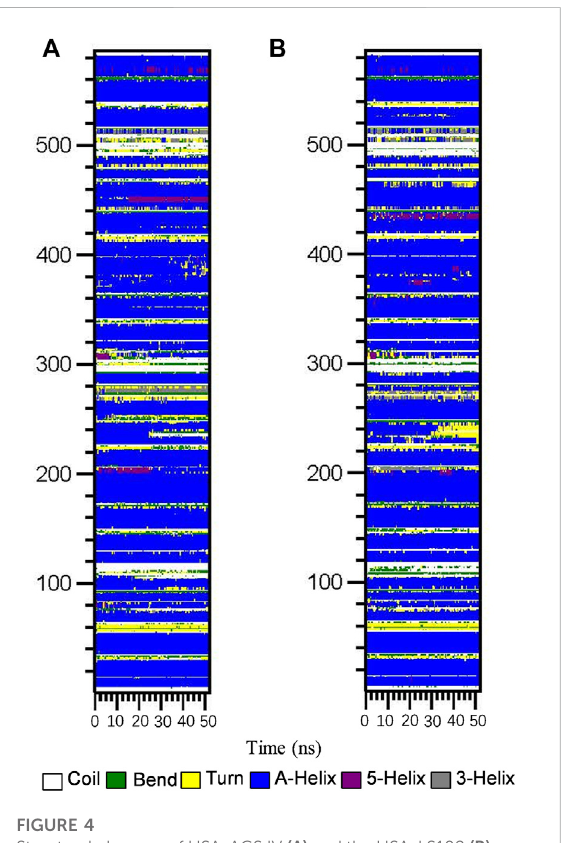
FIGURE 4 Structural changes of HSA-AGS IV (A) and the HSA-LS102 (B) complex during